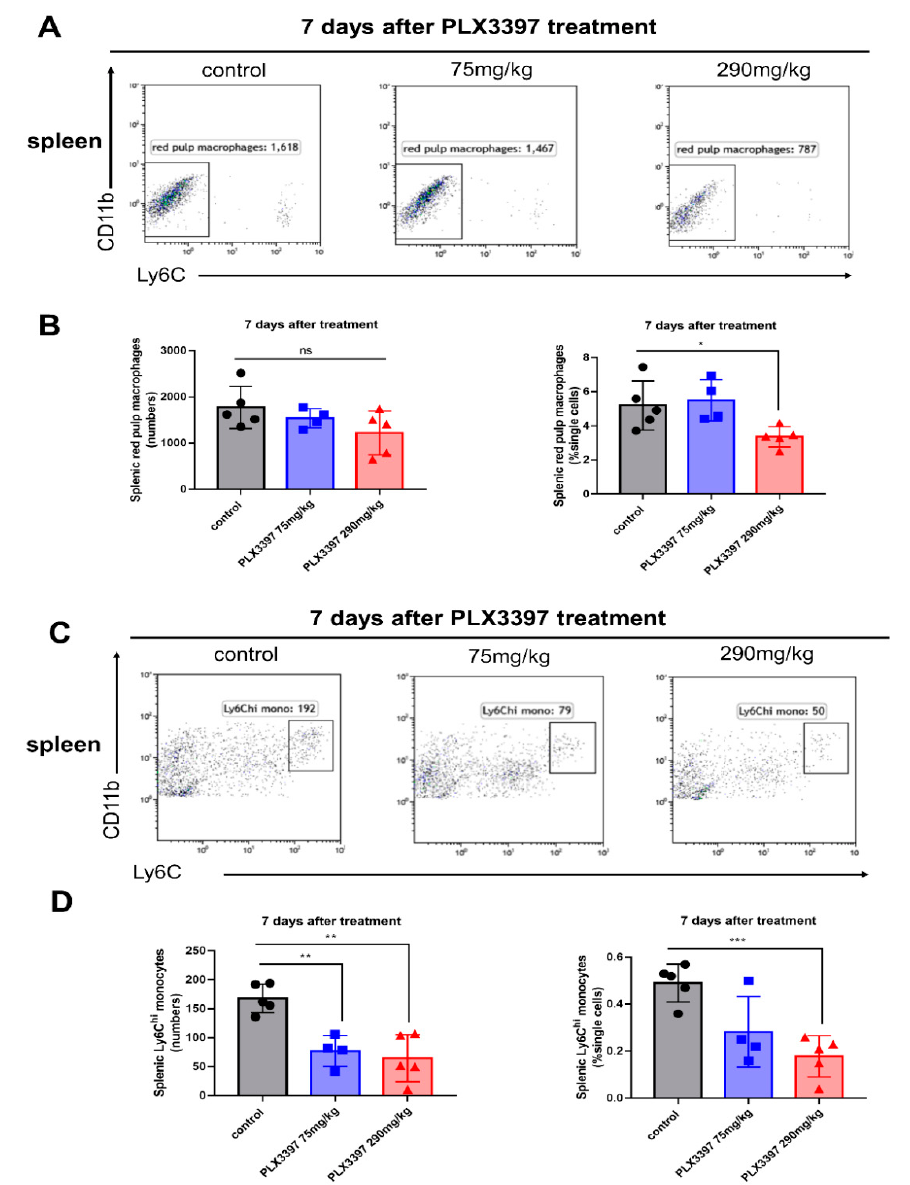
Figure 6. Dose-dependent peripheral effects following pharmacological microglial depletion. ( A ) Representative flow cytometry plots of splenic red pulp macrophages following 7 consecutive days of PLX3397 diet treatment with different doses of 75 mg/kg and 290 mg/kg, respectively. Control mice were treated with normal diet. ( B ) The numbers and percentages of red pulp macrophages (± SEM) in the spleen following PLX3397 diet with different doses (control, black bars; 75 mg/kg PLX3397 diet, blue bars; 290 mg/kg PLX3397 diet, red bars, n = 5, 4, 5, respectively). ( C ) Representative flow cytometry plots of splenic Ly6C hi monocytes following 7 consecutive days of PLX3397 diet treatment with different doses. Control mice were treated with normal diet. ( D ) The numbers and percentages of splenic Ly6C hi monocytes (± SEM) following PLX3397 with different doses (control, black bars; 75 mg/kg PLX3397 diet, blue bars; 290 mg/kg PLX3397 diet, red bars, n = 5, 4, 5, respectively). Statistical significance is indicated as * p < 0.05, ** p < 0.01 and *** p < 0.001. 2.7. Intracisternal Injection of PLX3397 Does Not Exert Significant Influence on Splenic Myeloid